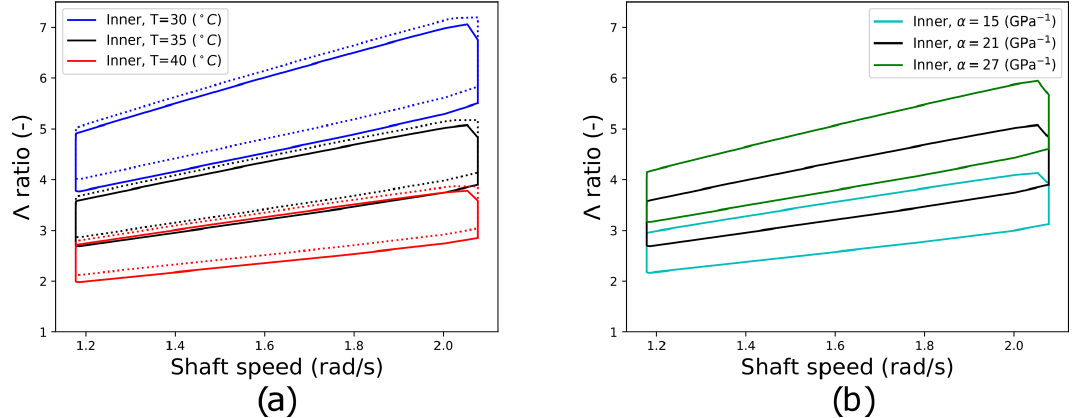
Figure D1. Graphical results for sensitivity analyses on load and α ∗ values. Panel (a) shows original results as solid lines, along with results obtained after all roller load values are halved (dotted lines). All three temperatures levels are included. Panel (b) shows the standard case, along with results obtained when α ∗ is increased and decreased by 6GPa − 1